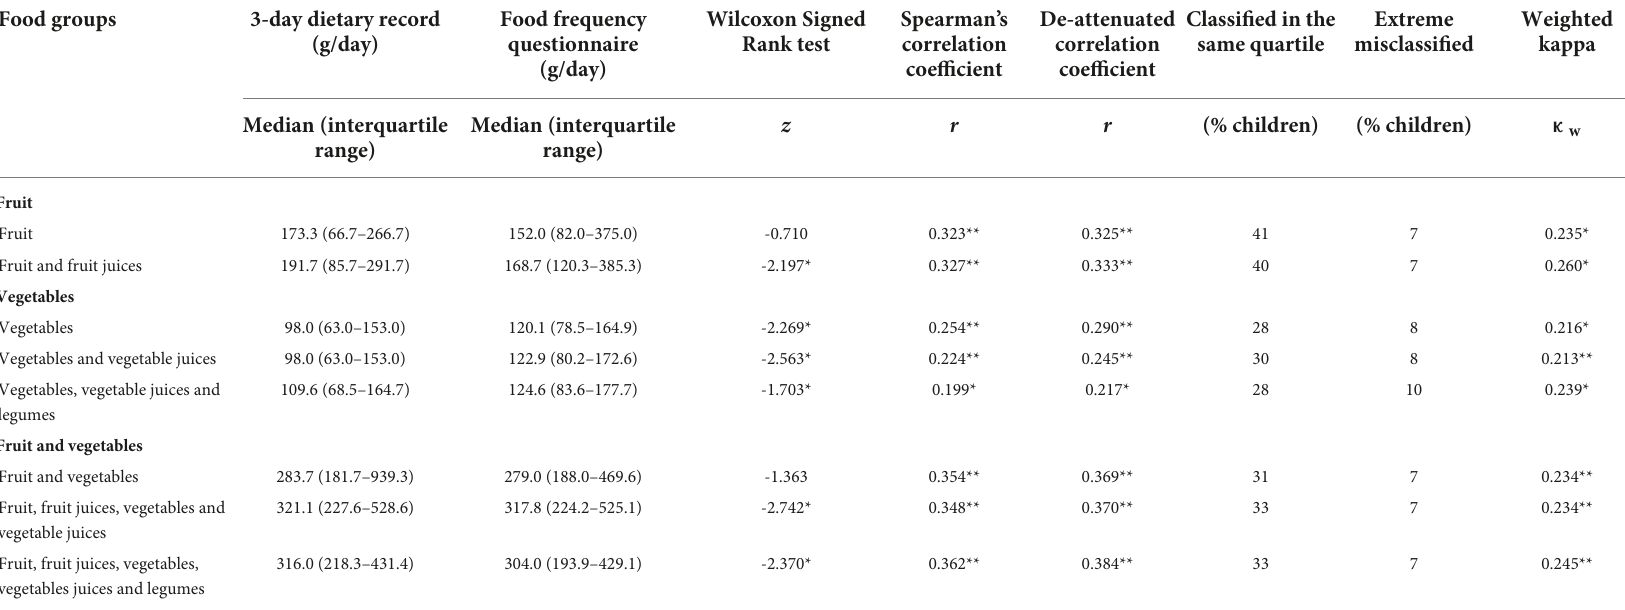
TABLE 2 Relative validity and median values for food frequency questionnaire and 3-day dietary record for the fruit and vegetable consumption in school-aged children ( N = 141). a